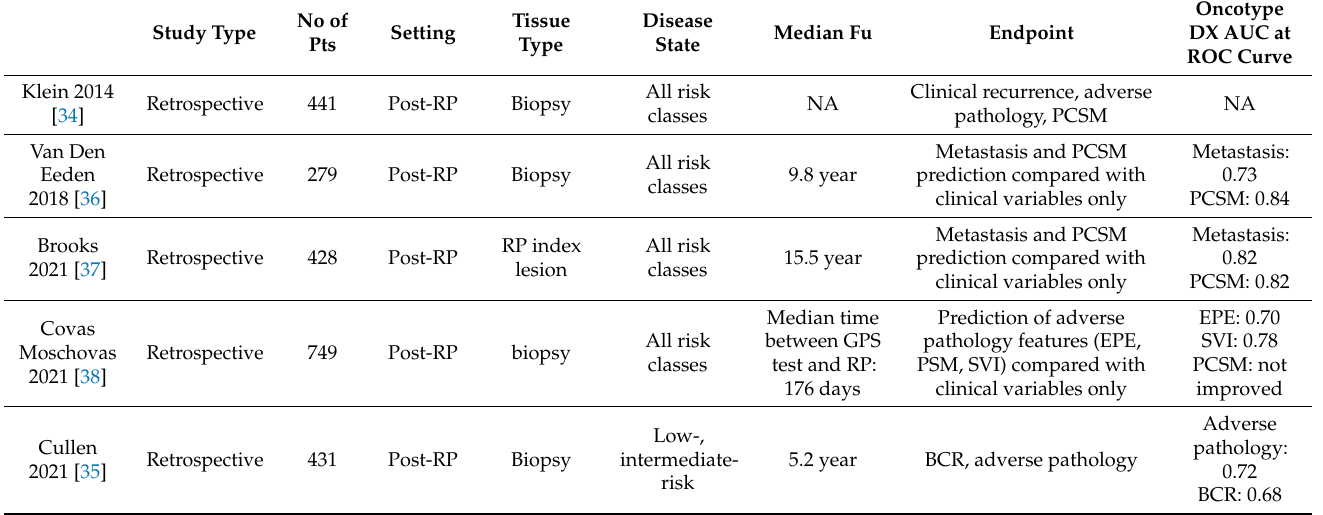
Table 4. Oncotype DX